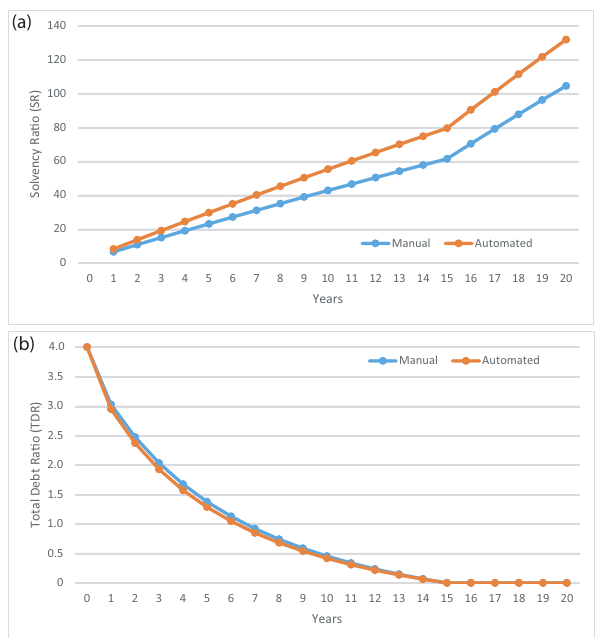
Figure 16. Comparative financial ratios for manual and automated maneuvers: ( a ) solvency ratio (SR), and ( b ) total debt ratio (TDR).